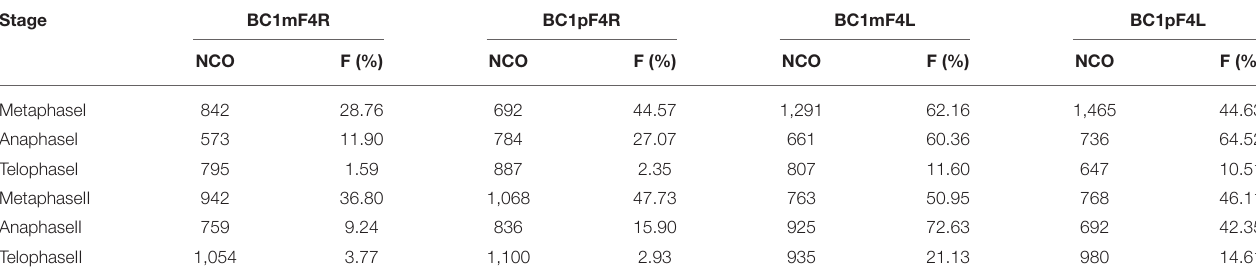
TABLE 3 | Frequency of meiotic abnormalities in the glyphosate- or glufosinate-tolerant fourth-generation progenies of the first backcross generation.